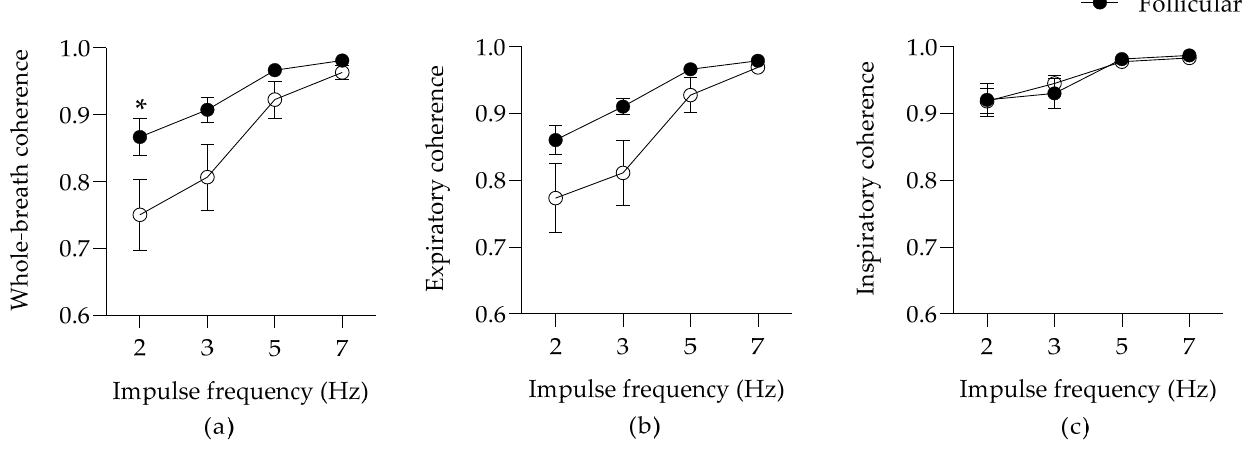
Figure 3. Coherence (means ± SEM) during whole-breath ( a ), expiration ( b ), and inspiration ( c ). * p < 0.05 between the estrus phases with Bonferroni’s multiple comparison tests.